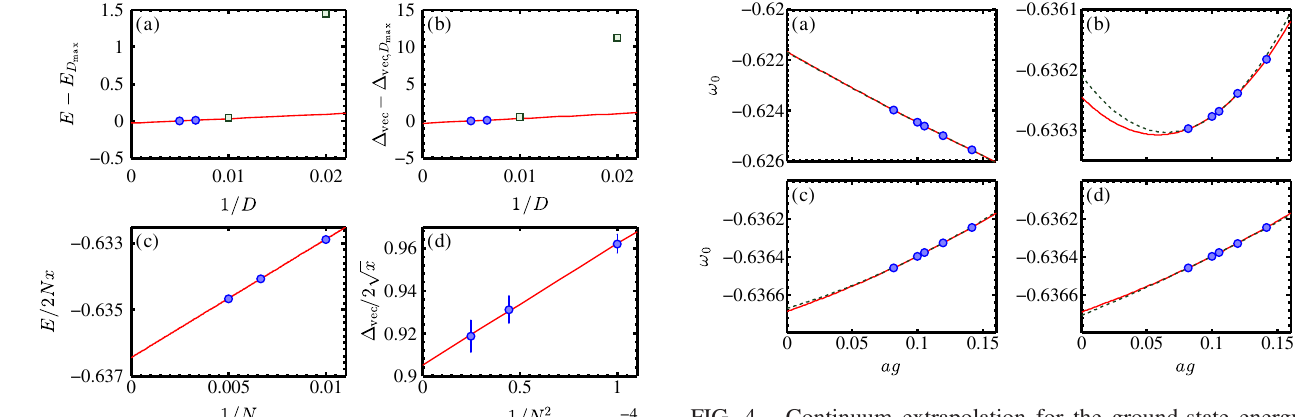
FIG. 4. Continuum extrapolation for the ground-state energy 1 = 2 (a), j 1 (b), j density for m=g ¼ 0 . 3 and j max ¼ max ¼ max ¼ 3 = 2 (c), and j 2 (d). The red line shows the quadratic fit FIG. 3. Upper row: Extrapolation in bond dimension for the max ¼ through all data points used to extract the central value. The ground-state energy (a) and the vector mass gap (b) for 2 , N ¼ 150 , and x ¼ 150 . The central value dashed green line shows a quadratic fit omitting the largest lattice m=g ¼ 0 . 3 , j max ¼ spacing to estimate the systematic error of the central value. is determined with a linear fit through the largest two bond dimensions represented by the blue dots. Lower row: Extrapo- lation to the thermodynamic limit for the ground-state energy 2 and x ¼ 150 . density (c) and the vector mass gap (d) for j max ¼